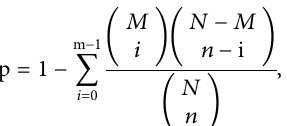
Frontiers in Genetics |